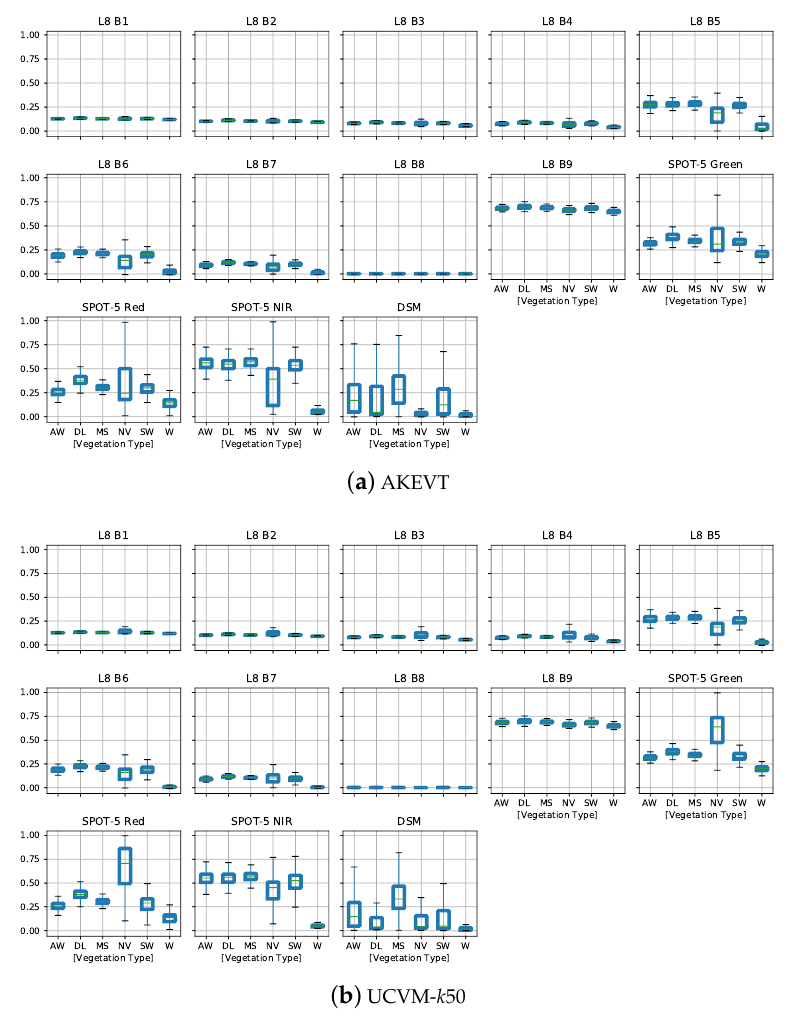
Figure 8. Box-plots representing variability of Landsat 8 (L8 B1–B9) TOA values, SPOT-5 data (green, red, NIR) normalized values, and IfSAR DSM normalized values for the AKEVT ( a ) and UCVM ( b ) maps, showing spectral differences described in Section 4.2. The values were segregated by vegetation type, where AW, DL, MS, NV, SW, and W stand for Alder-Willow Shrub, Dryas/Lichen Dwarf Shrub Tundra, Mixed Shrub-Sedge Tussock Tundra-Bog, Non-Vegetated, Sedge-Willow-Dryas Tundra, and Water,